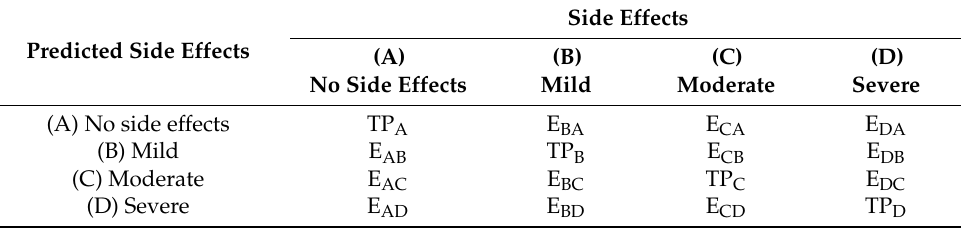
Table 7. Confusion matrix of the predicted side effects with different severity levels versus the actual numbers.